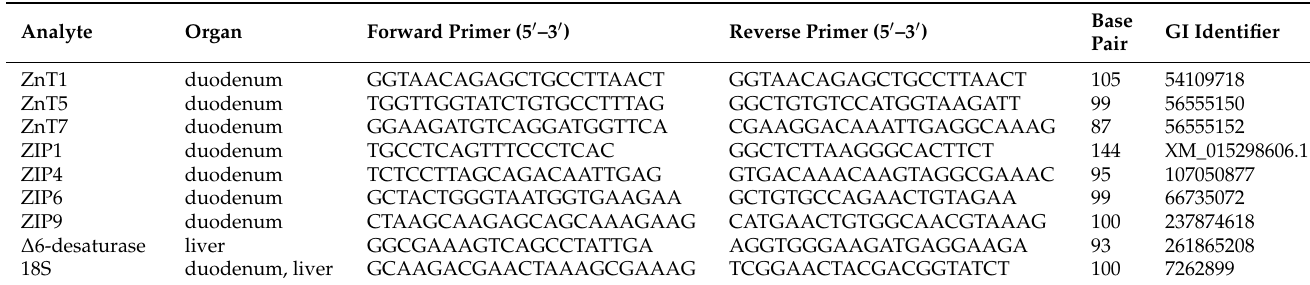
Table 1. The DNA sequences of primers used in this study: ZnT1, zinc transporter 1; ZnT5, zinc transporter 5; ZnT7, zinc transporter 7; ZIP1, zinc transport protein 1; ZIP4, zinc transport protein 4; ZIP6, zinc transport protein 6; ZIP9, zinc transport protein